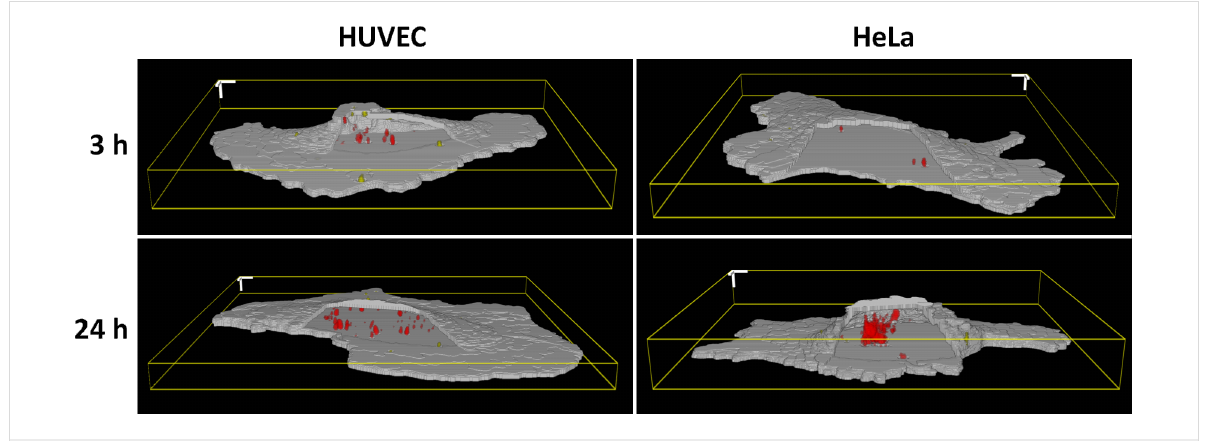
Figure 2: Cell type-dependent uptake kinetics of silica nanoparticles. The figure shows representative three-dimensional reconstructions of 310 nm silica nanoparticles interacting with HUVEC or HeLa cells after 3 and 24 h. The membrane region outlining the cells appears in gray. A window was purposefully open in the 3D perspectives so as to allow the visualization of intracellular particles (in red). Particles situated within the membrane region are shown in yellow. An increasing number of particles taken up in the cells over time is clearly observed for both cell types, while being much more prominent for HeLa cells. 3D scale bars = 5 µm.